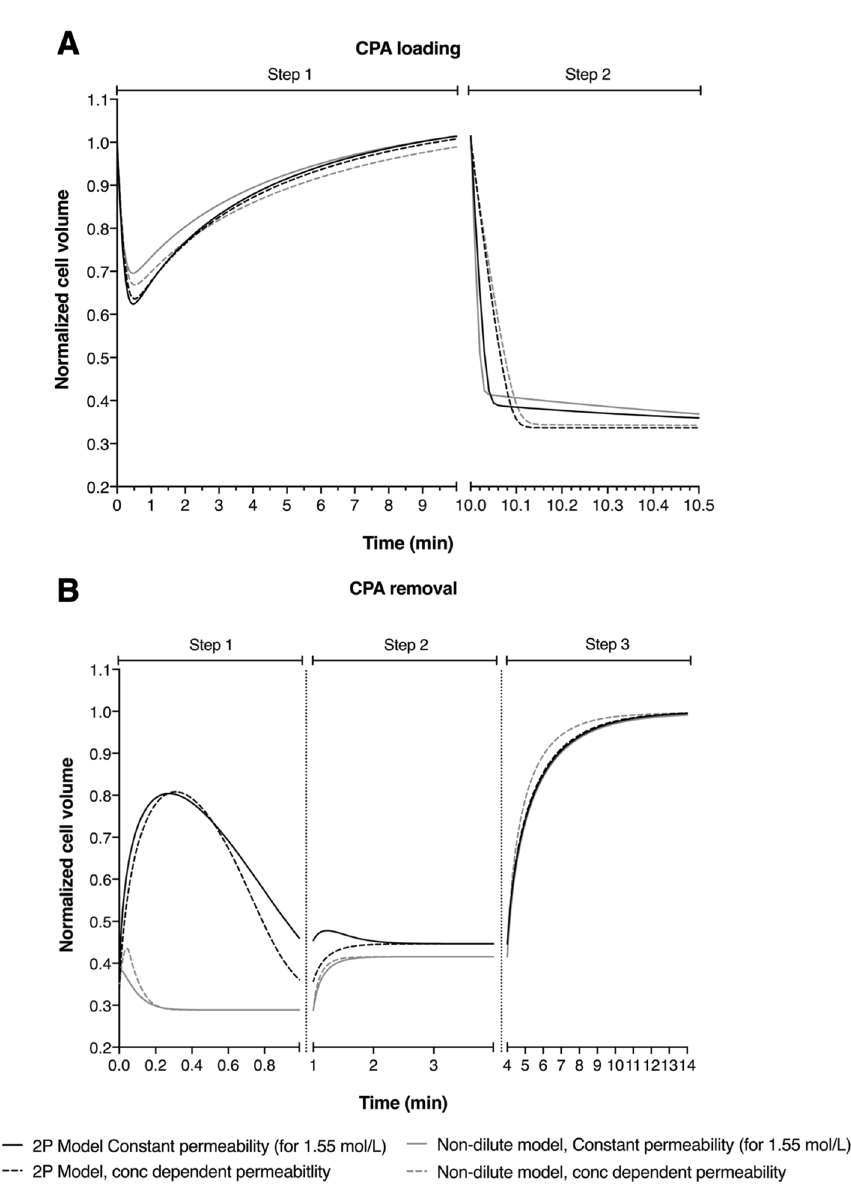
Figure 4. Comparative simulation of cell volume excursion of GV-stage bovine oocytes during CPA addition ( A ) and removal ( B ) following the Kuwayama protocol for the 2P model (black line) and nondilute model (gray line) using constant (solid line) and non-constant permeability parameters (dotted